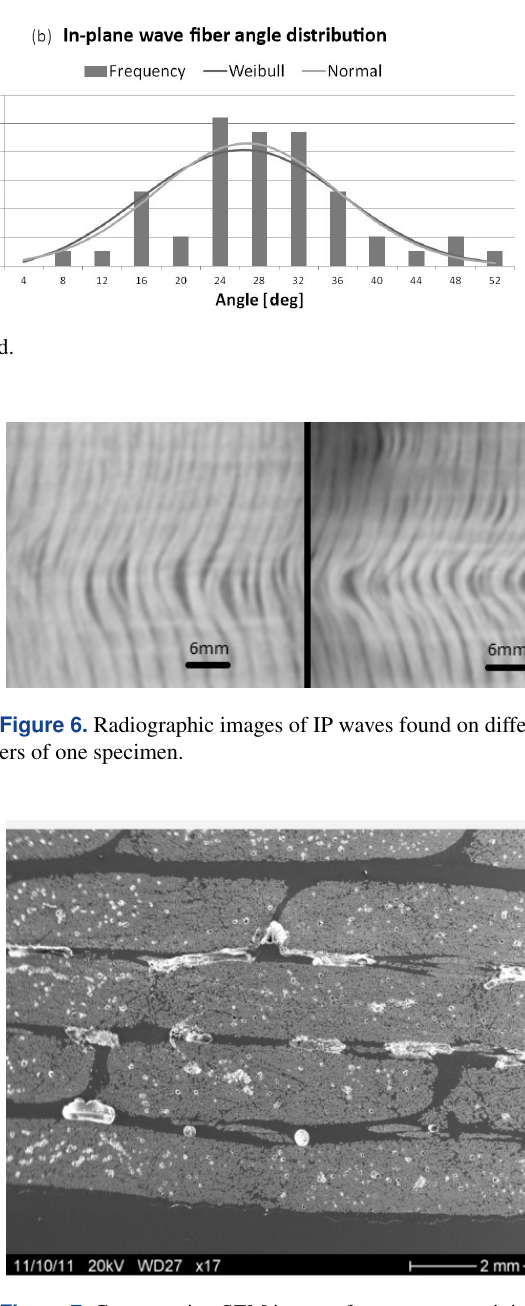
Figure 7. Cross-section SEM image of a coupon containing poros-